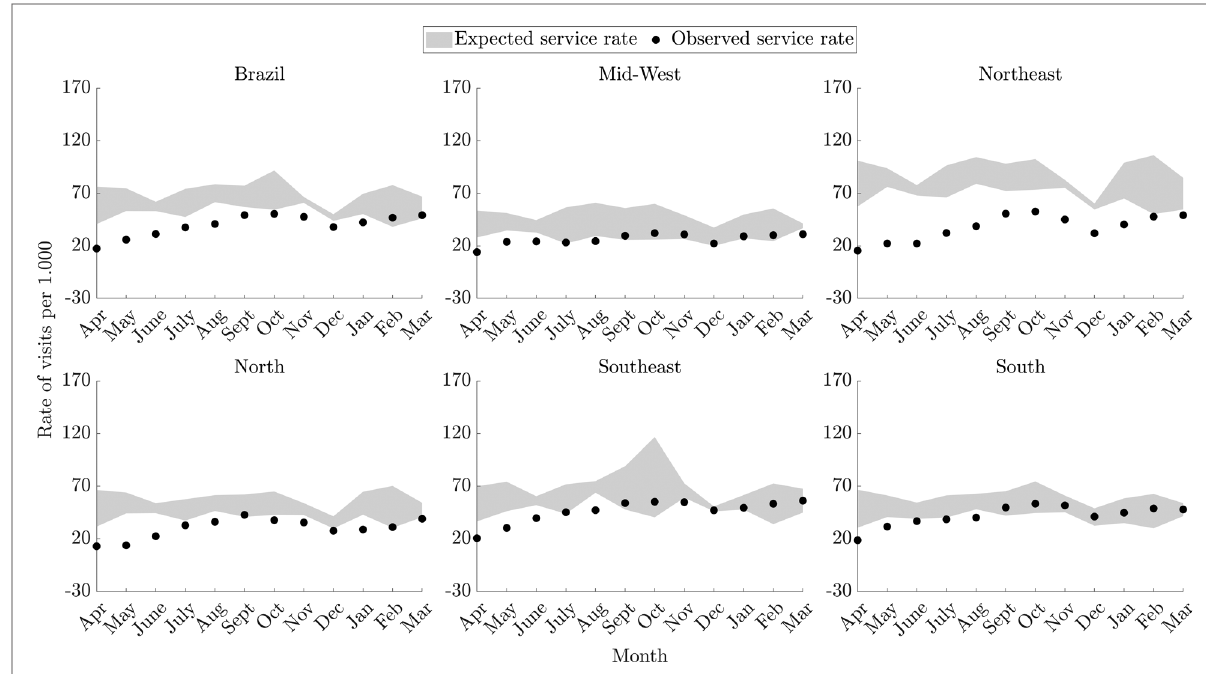
FIGURE 1 Monthly rates of visits (per thousand children up to fi ve years of age) to monitor the growth and development of children, according to regions in primary health care services in Brazil. In gray: expected rates – pre-pandemic period (from April 2017 to March 2020); dots in black: observed rates – during the pandemic (from April 2020 to March 2021); the shaded areas indicate the average +/ − 1.96 standard deviations for expected service